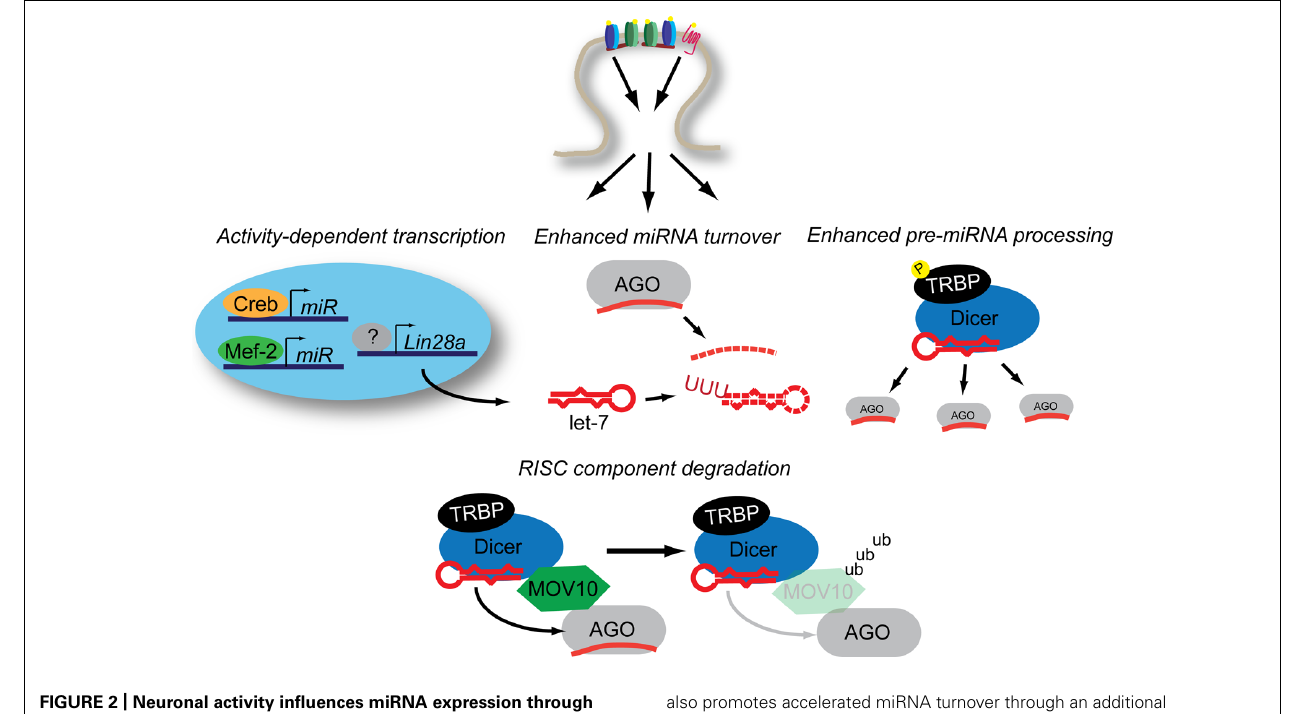
FIGURE 2 | Neuronal activity influences miRNA expression through multiple mechanisms. Activity-dependent transcription induces miRNA production through Mef2 and Creb while Lin28a increases expression through an uncertain combination of transcription-dependent and -independent mechanisms. Increased levels of Lin28a lead to destabilization of pre-let-7 transcripts through poly-uridynylation. Activity